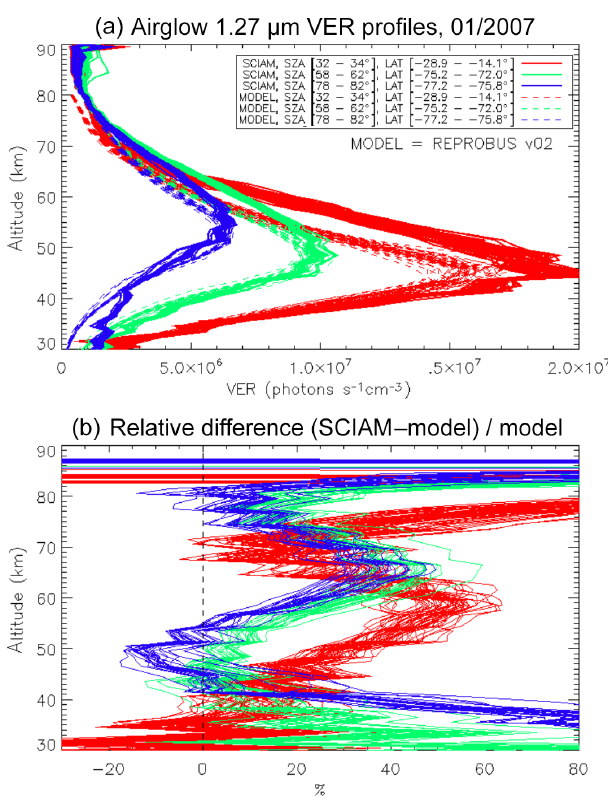
Figure 13. (a) Comparisons of all SCIAMACHY and REPROBUS airglow VER profiles for the first 3d of January 2007 in three SZA domains: SZAs of 32–34 ◦ (red curves), SZAs of 58–62 ◦ (green curves), and SZAs of 78–82 ◦ (blue curves). Only profiles from the Southern Hemisphere were selected. (b) For each profile, relative difference (SCIAMACHY − REPROBUS )/ REPROBUS is